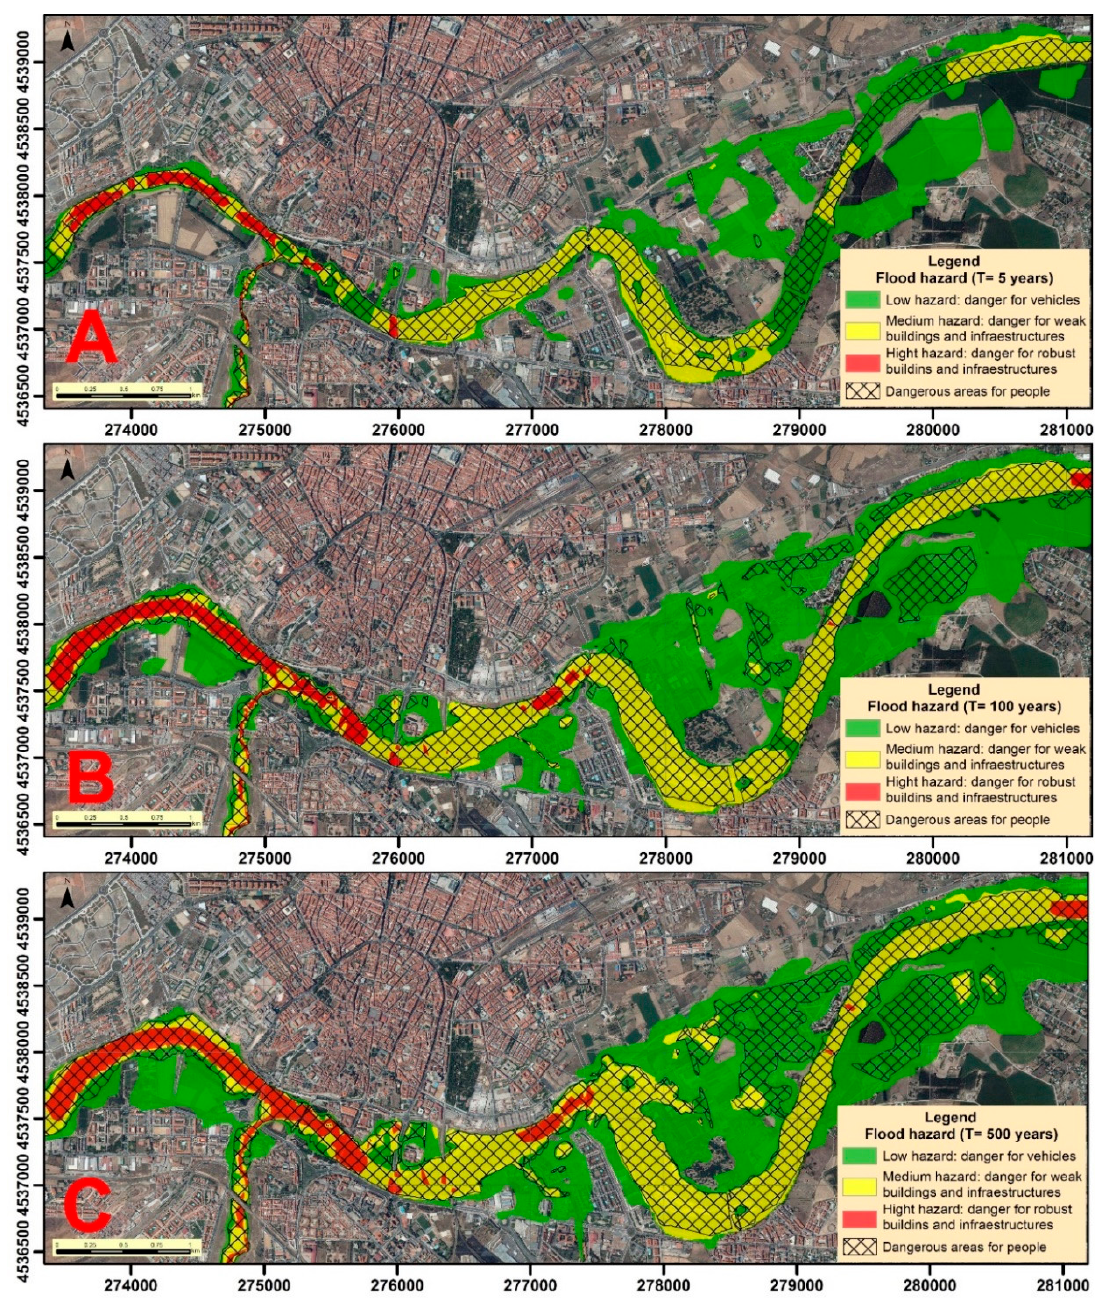
Figure 6. Hazard maps for each return period: ( A ) T = 5 years; ( B ) T = 100 years; and ( C ) T = 500 years